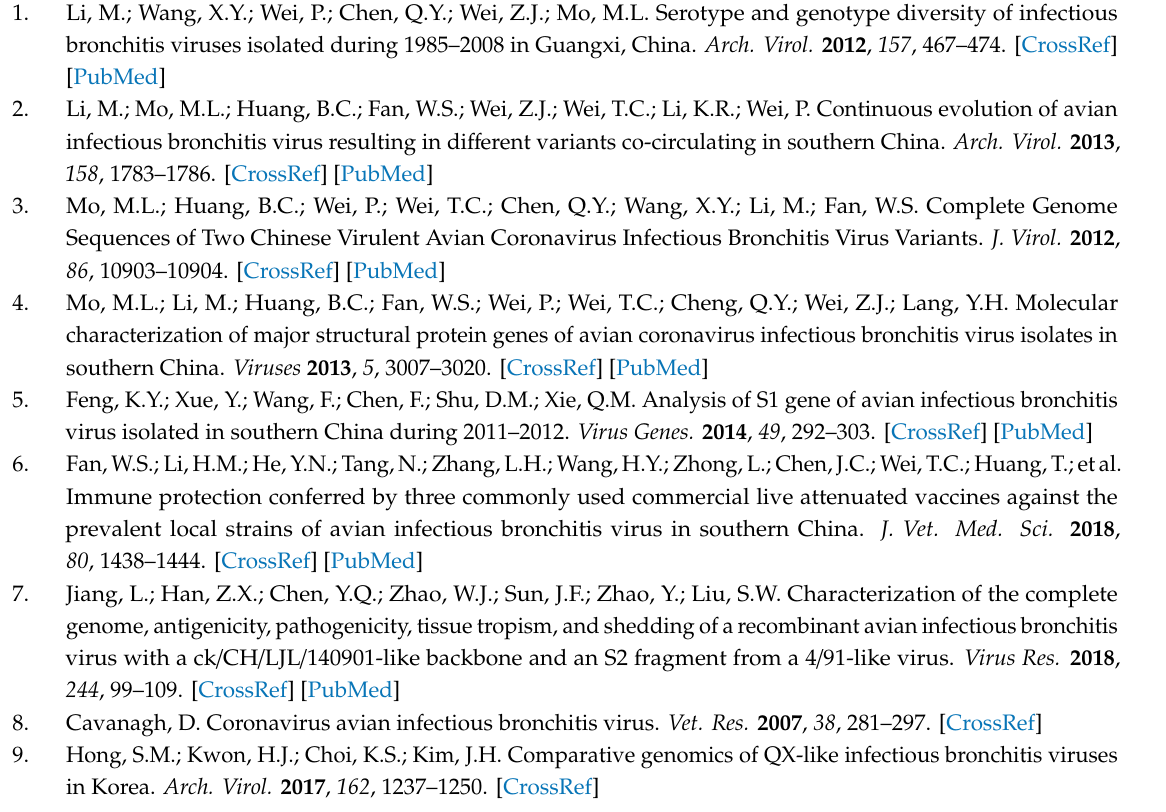
Table S1: IBV reference strains used in this study; Table S2: Estimates of evolutionary distances over sequence pairs between groups of S1 gene; Table S3: Estimates of evolutionary distances over sequence pairs between groups of E gene; Table S4: Estimates of evolutionary distances over sequence pairs between groups of M gene; Table S5: Estimates of evolutionary distances over sequence pairs between groups of N gene; Table S6: The selection profile and entropy values of S1, E, M, and N proteins of Guangxi IBV isolates; Figure S1: Alignment of the deduced amino acid sequences of the S1 subunit of the spike protein of 6 IBV isolates (New-type 1 or GVI-1) and other strains. The insertion of critical amino acids 303, 304, 305, 306, and 394 are highlighted in red; Figure S2: The sequences were aligned using the Clustal W method in the BioEdit version 7.1.11.0 package. The hotspot sequence ATTTT(T / A) (green underline) was found near the breakpoint site (red box) of the S1 subunit gene in all of recombinant isolates except GX-YL170805. The GX-YL170805 isolate hotspot sequence and breakpoint site were marked in blue box; Figure S3: Entropy plot of amino acid of S1 (a), E (b), M (c), and N (d) protein genes of IBVs. X-axis shows the amino acid sites of S1, E, M, and N genes; y-axis shows the entropy of each amino acid site; Figure S4: The location of positive selection sites and putative glycosylation sites of the S1 subunit of 91 IBV isolates. The positively selected sites and N-glycosylation site are highlighted in red and blue separately; Figure S5: The location of positive selection sites and putative glycosylation sites of the E subunit of 91 IBV isolates. The positively selected sites and N-glycosylation site are highlighted in red and blue separately; Figure S6: The location of positive selection sites and putative glycosylation sites of the M subunit of 91 IBV isolates. The positively selected sites and N-glycosylation site are highlighted in red and blue separately; Figure S7: The location of positive selection sites and putative glycosylation sites of the N subunit of 91 IBV isolates. The positively selected sites and N-glycosylation site are highlighted in red and blue